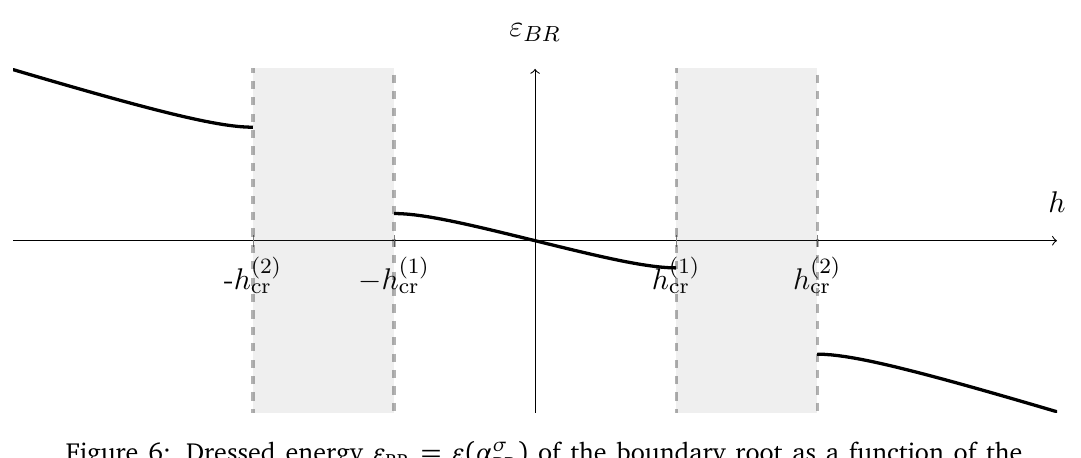
Figure 6: Dressed energy (cid:34) boundary field h = h σ at ∆ = 3, as given by (4.33), in its domain of existence (4.26). The two critical fields are here h ( 1 ) odd and decreasing function of h . Moreover, the dressed energy of the boundary root tends to the one of a hole with rapidity ˇ λ tends to the one of a hole with rapidity ˇ λ